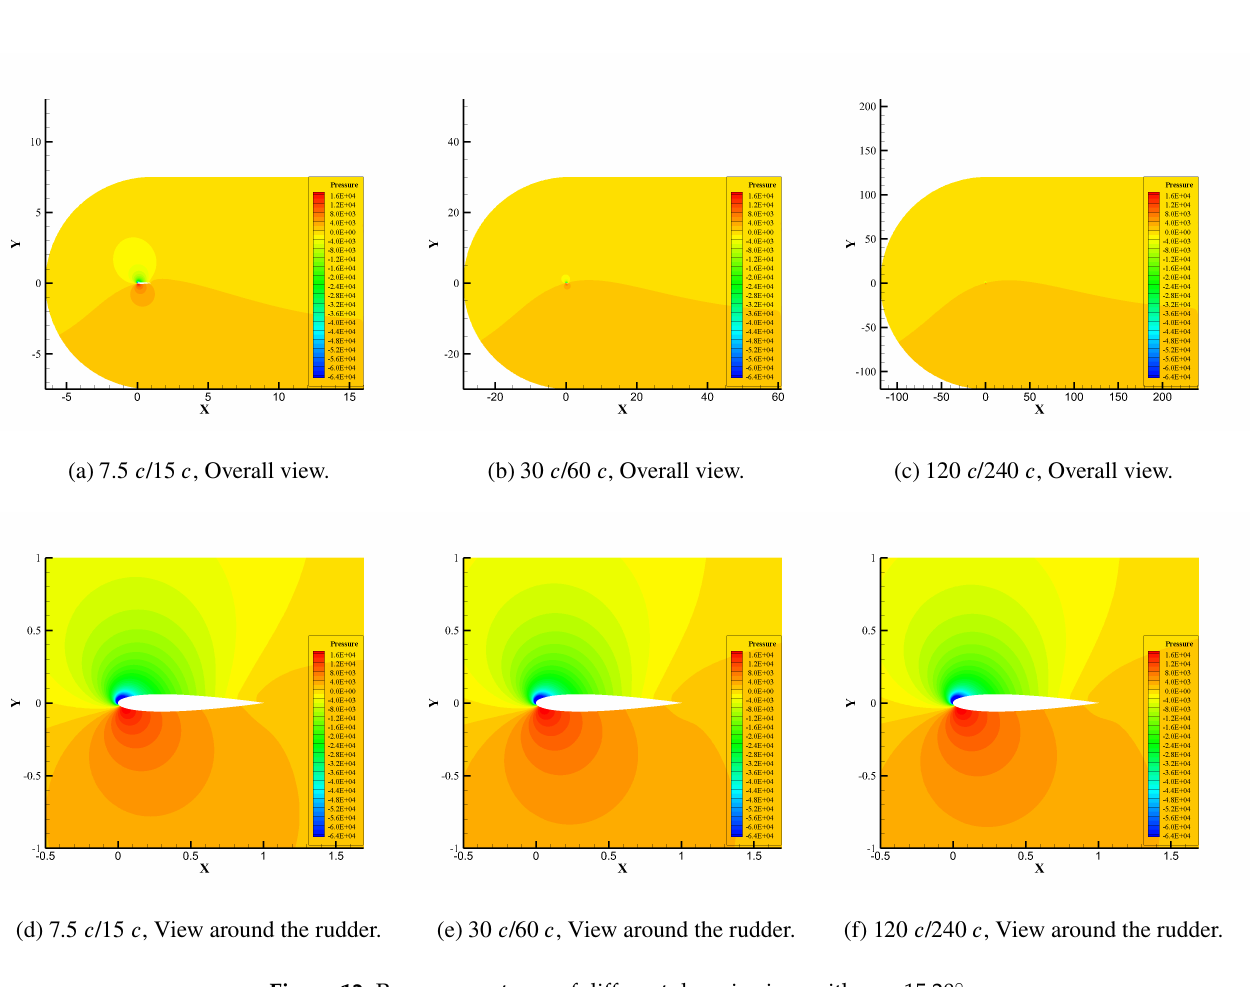
Figure 12. Pressure contours of different domain sizes with α = 15.20 ◦ . Table 6. Uncertainty estimations for 4 cases (30 c /60 c , NOC = 203,144, 251,065, 423,225, 524,605, α = 15.2 ◦ ) based on mesh